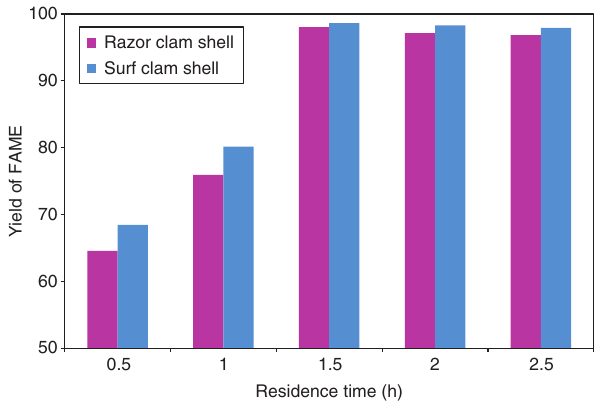
Figure 7: Effect of residence time on % yield of fatty acid methyl ester (FAME) (catalyst bed length 250 mm, reaction temperature 60 ° C, and methanol/oil molar ratio 15:1).